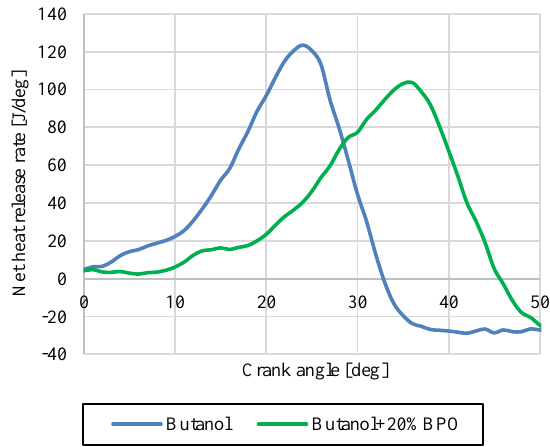
Fig. 14. In-cylinder pressure vs. volume The p-V diagram shows a lower pressure peak for Buta- nol + 20% BPO. The maximum pressure recorded during the indication for this fuel was 3.35 MPa. For pure butanol, the maximum pressure was 4.45 MPa. The maximum value for butanol occurred noticeably earlier, which indicates faster ignition of the fuel, and confirms the NHRR course presented in Fig. 15.